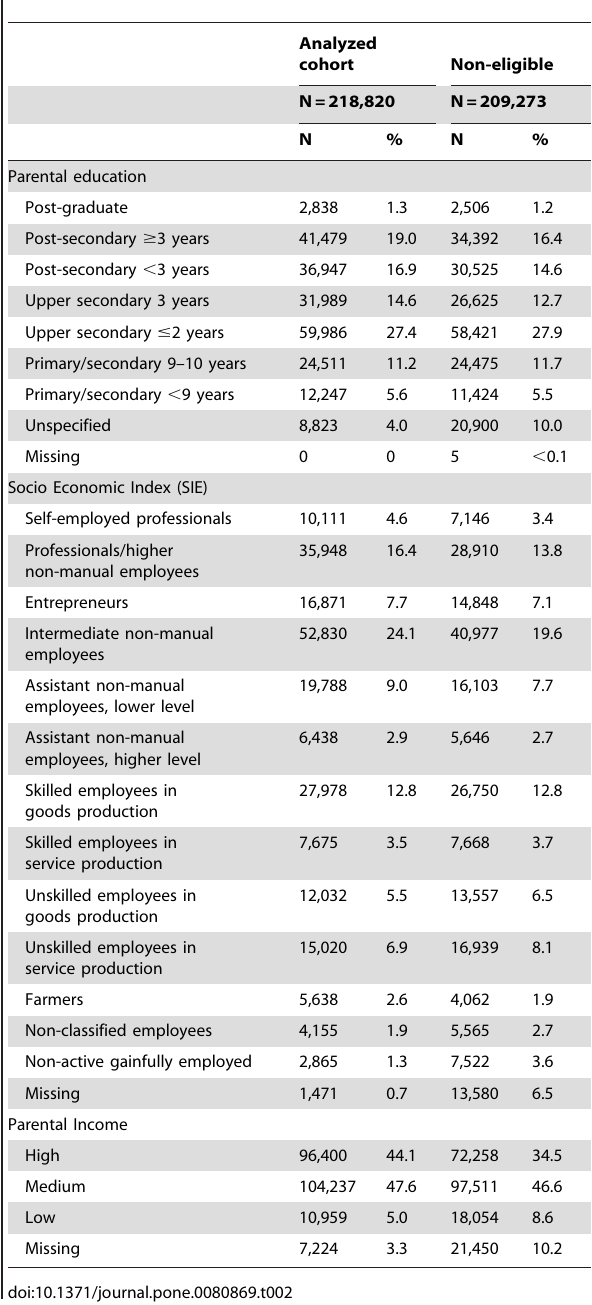
Table 2. Parental characteristics of analyzed cohort vs. non- eligible